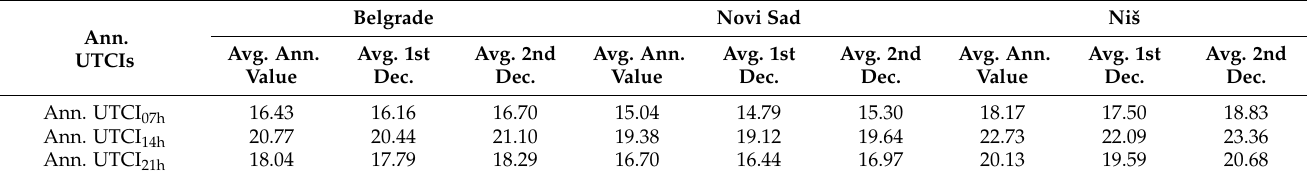
Table 7. Average annual UTCIs values in Belgrade, Novi Sad, and Niš for the period 1999–2018, and average annual decade-long UTCIs values for the 1st decade (1999–2008) and 2nd decade (2009–2018). Belgrade Novi Sad Niš Ann. Avg. Ann. Avg. 1st Avg. 2nd Avg. Ann. Avg. 1st UTCIs Value Dec. Dec. Value